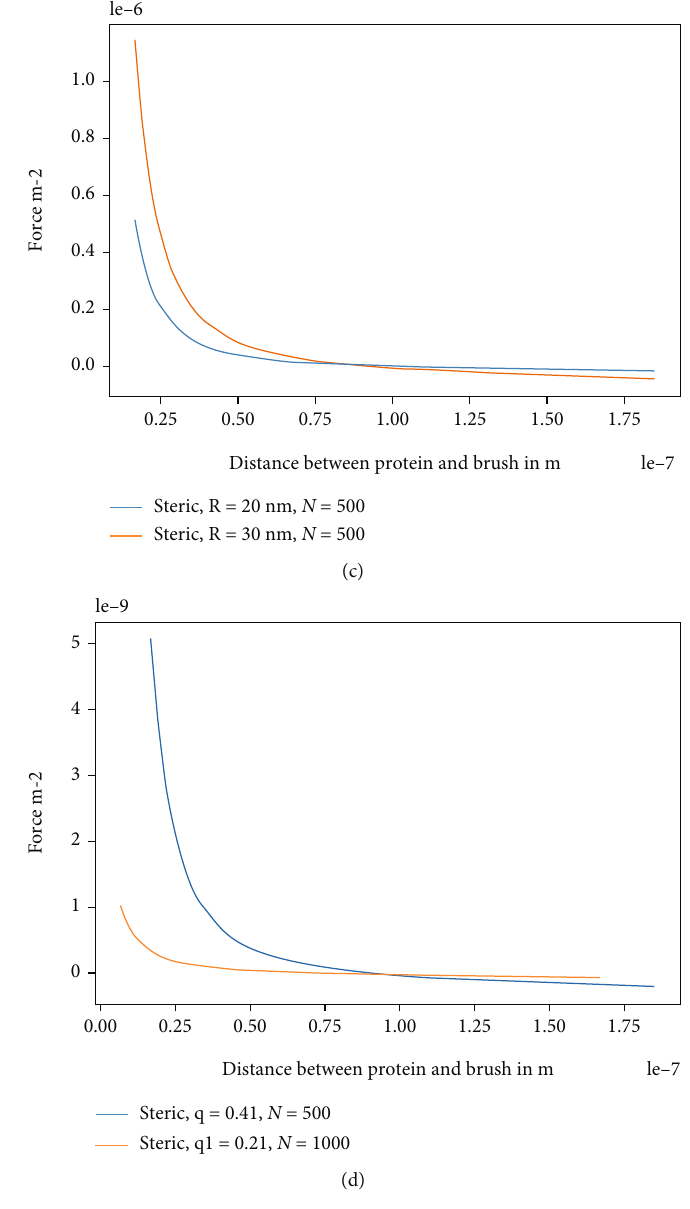
Figure 6: Plot of force as a function of the distance between the polymer brush and protein. (a) plot of the Vander Waals and repulsive forces. (b) Plot of the steric repulsive force for di ff erent degrees of polymerization. (c) Plot of the steric repulsive force for di ff erent sizes of proteins. (d) Plots of the steric repulsive force for di ff erent